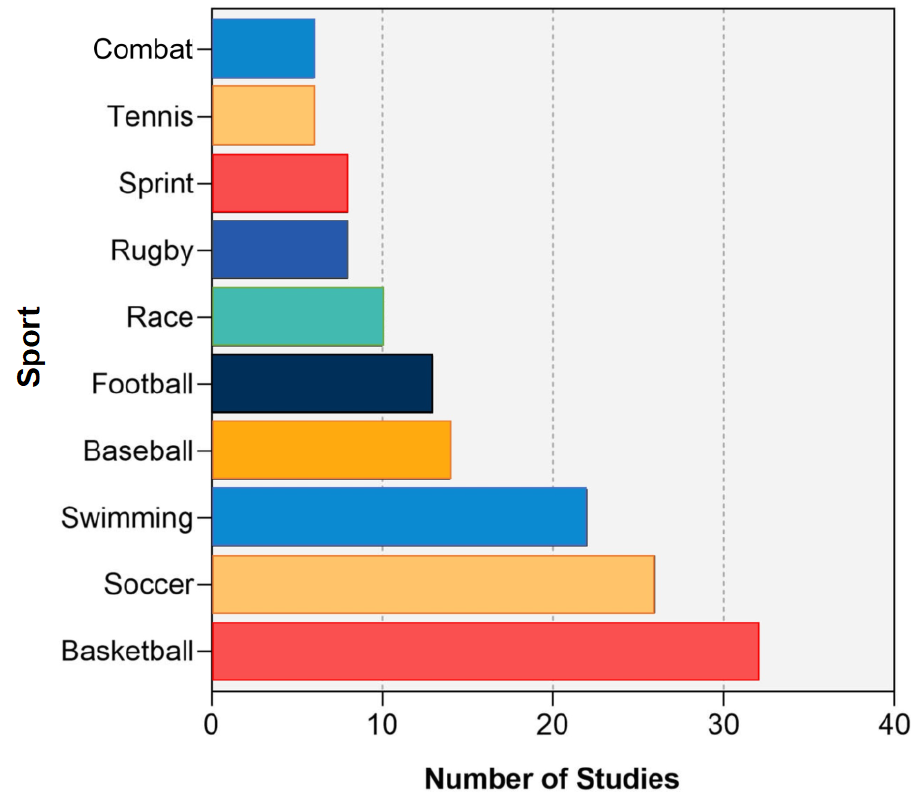
Figure 10. The top 10 most focused sports in adapted sport publication.